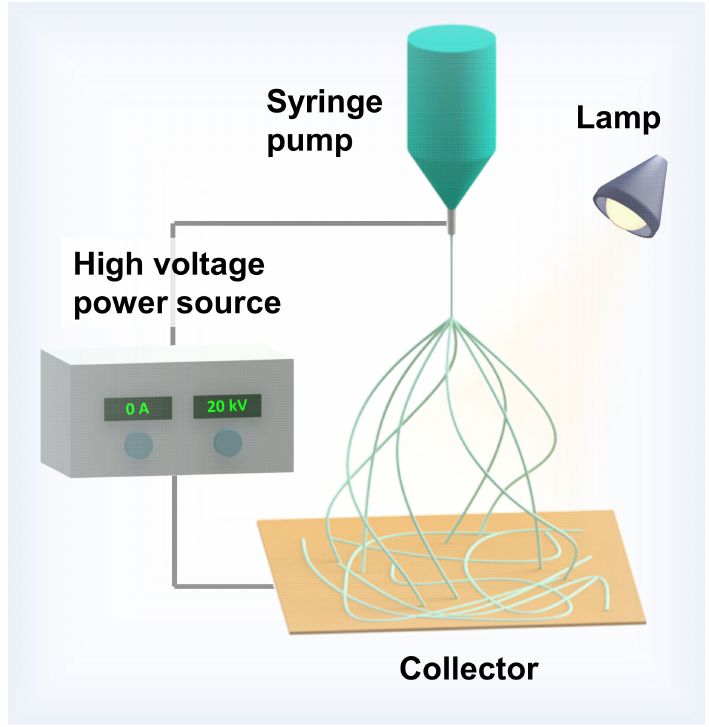
Figure 1. Description of structure and components of electrospinning equipment.